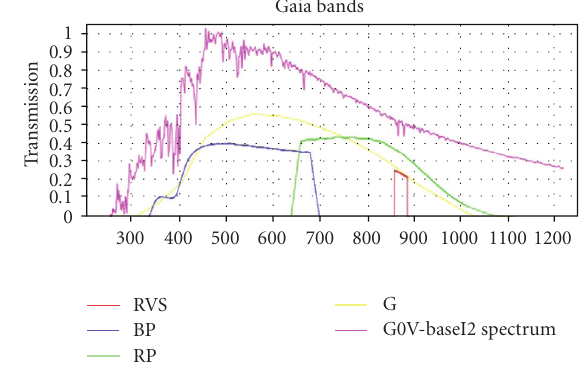
Figure 1: The spectral coverage by Gaia